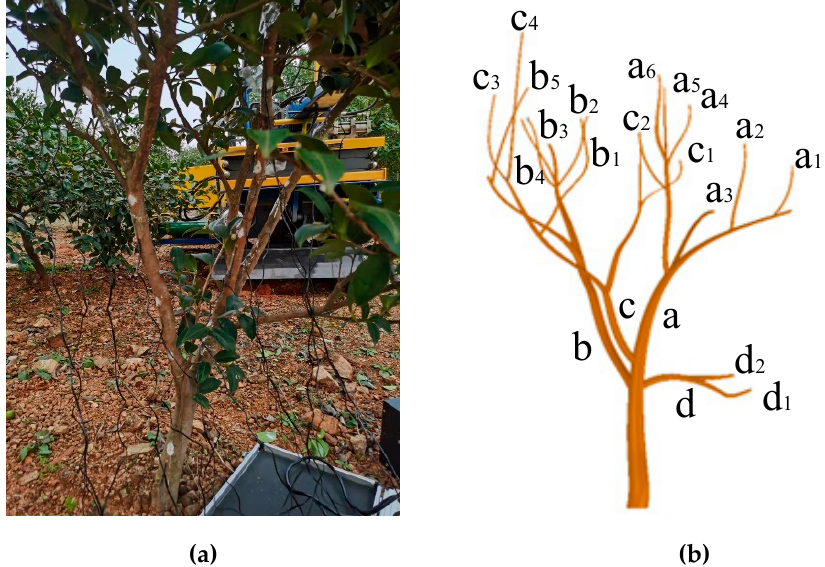
Figure 1. Camellia oleifera tree. ( a ) real photo; ( b ) 3D modeling. a, b, c, d represent different first-level branches of Camellia oleifera and a i , b i , c i , d i represent different second-level branches of Camellia oleifera